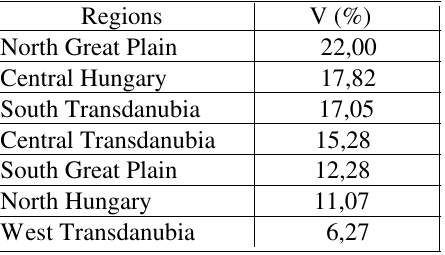
Table 2: Relative deviations of apple production in the different regions